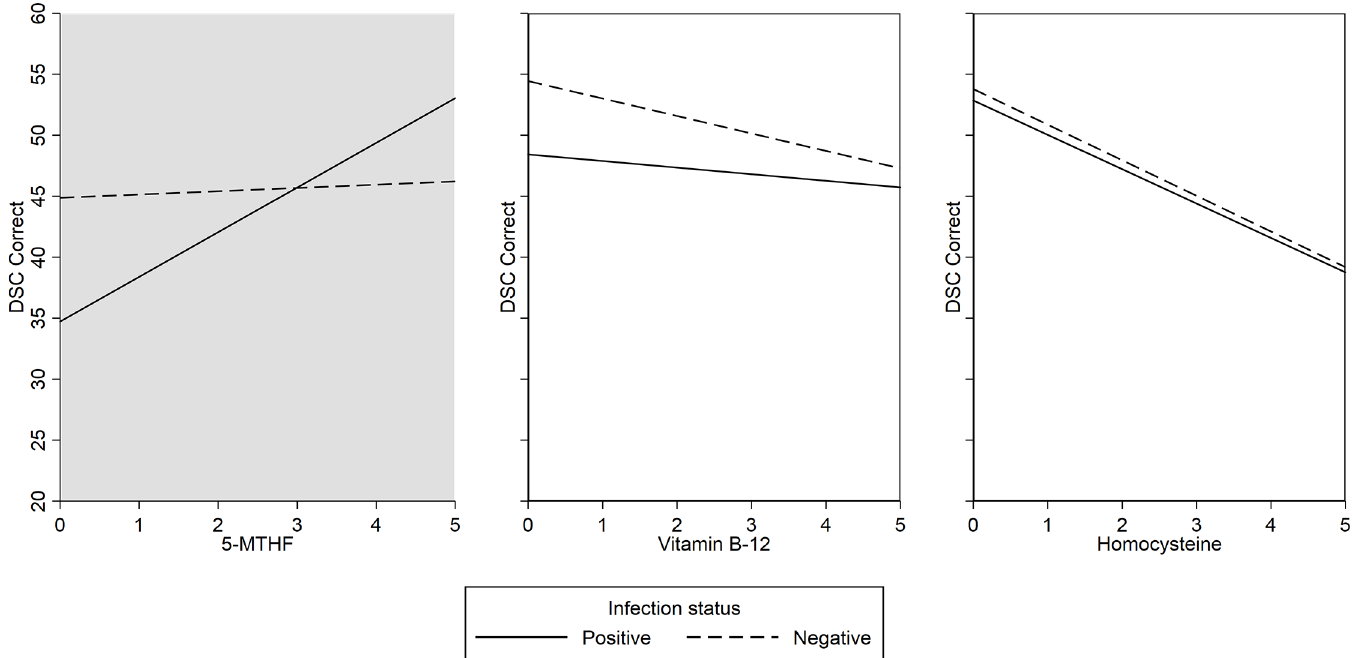
Fig 1. Number of correct DSC responses predicted from interactions of H . pylori infection status and multiple folate-cycle factors in adults aged 60 to 85 years. Note: Shadedplots indicate statistical significanceat the p = .05 level.